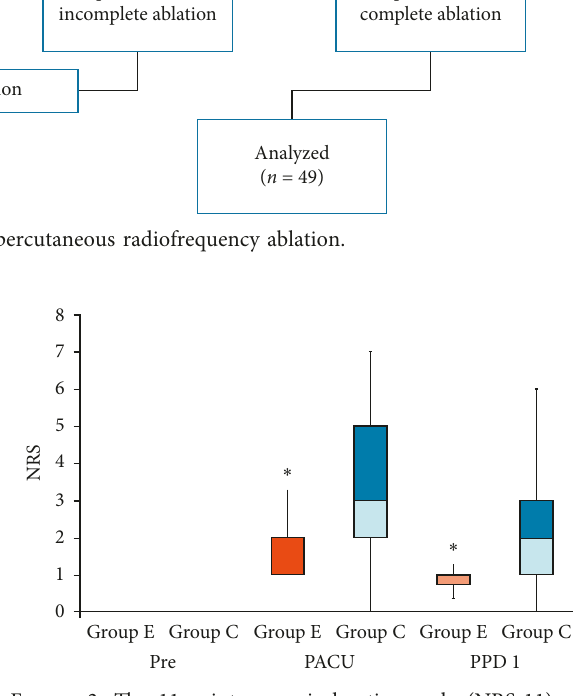
postanesthesia care unit; (cid:31)